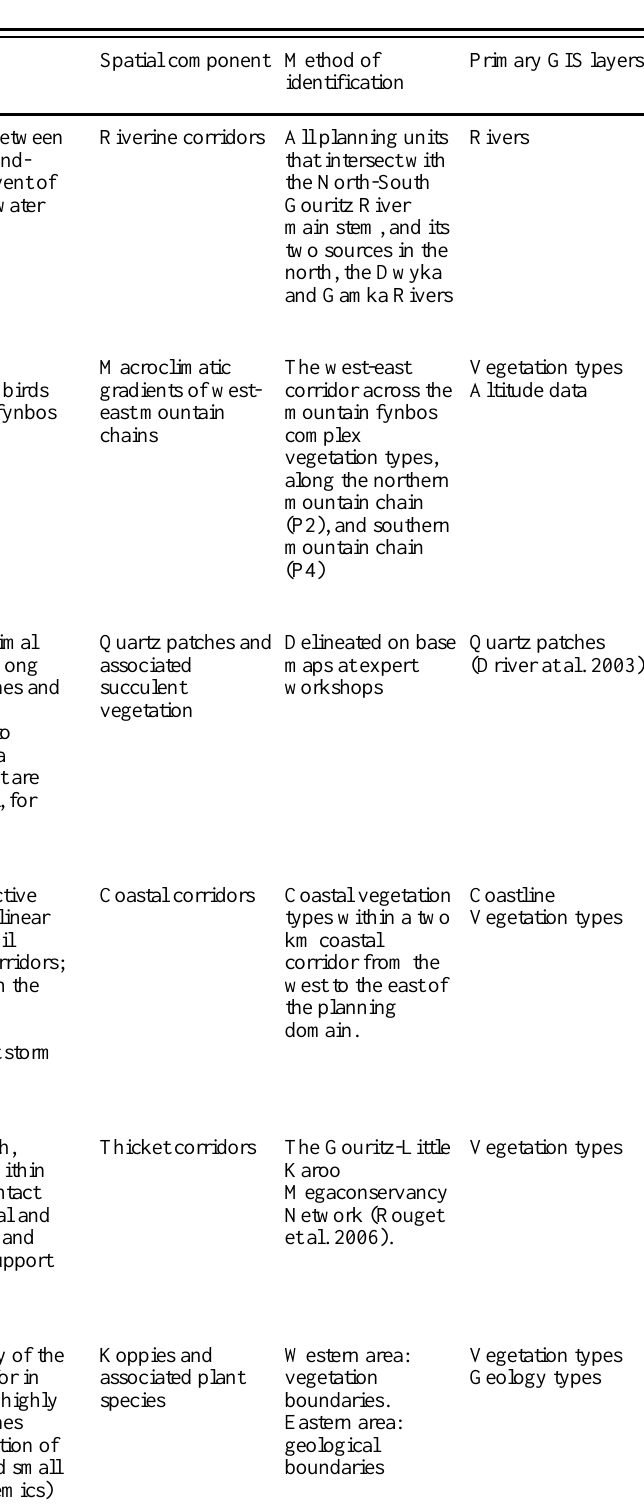
Table 1 . Nine broad-scale biodiversity processes, and their spatial surrogates, in the Gouritz planning domain. All spatial boundaries were matched to the closest planning unit boundary. The processes form the corridor network. Further details can be obtained from Lombard et al.